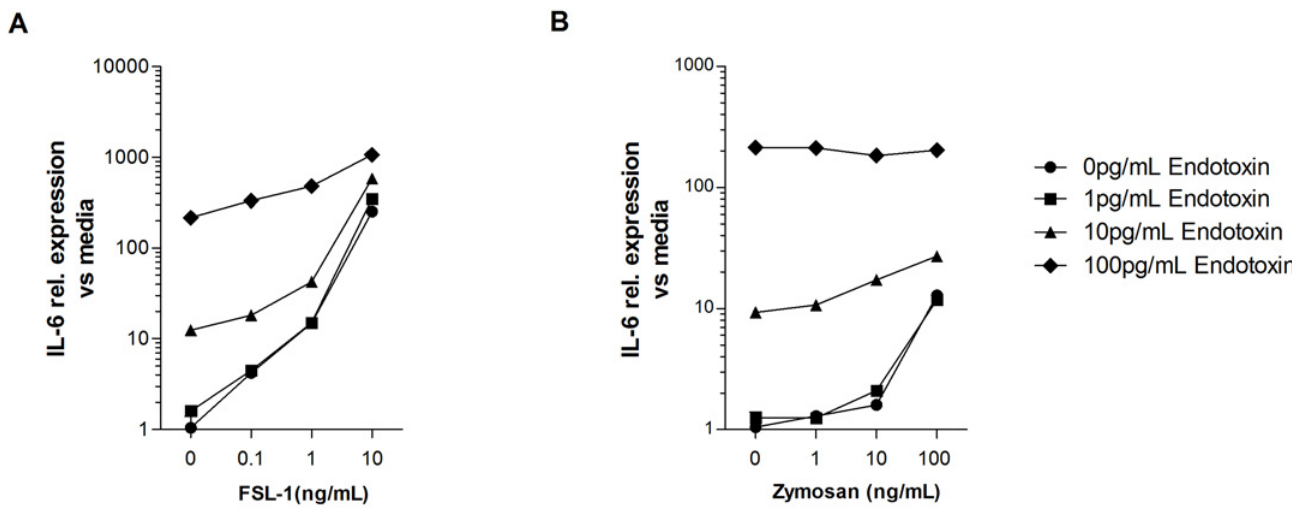
Fig 7. Multiple impurities do not modify the LLOD for each individual impurity. MM6 cells were cultured in the presence of increasing concentration of ( A ) Endotoxin and FSL-1 ( B ) Endotoxin and zymosan alone or in combination. mRNA level of IL-6 was quantified at 24h by q-RT-PCR. Each point represents mean ± SD of triplicate cell